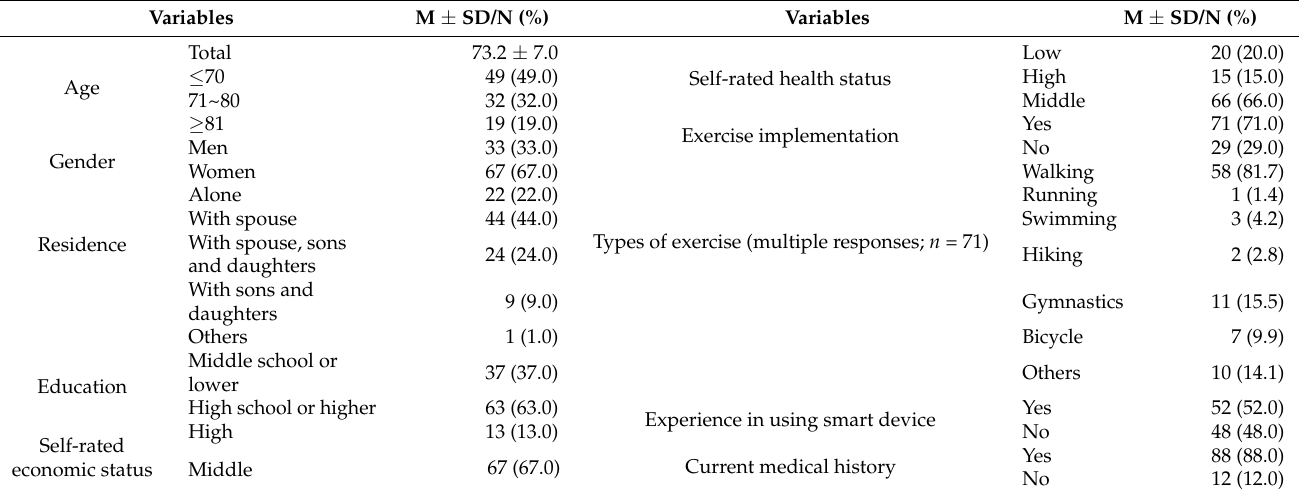
Table 1. Participants’ general characteristics (N = 100).